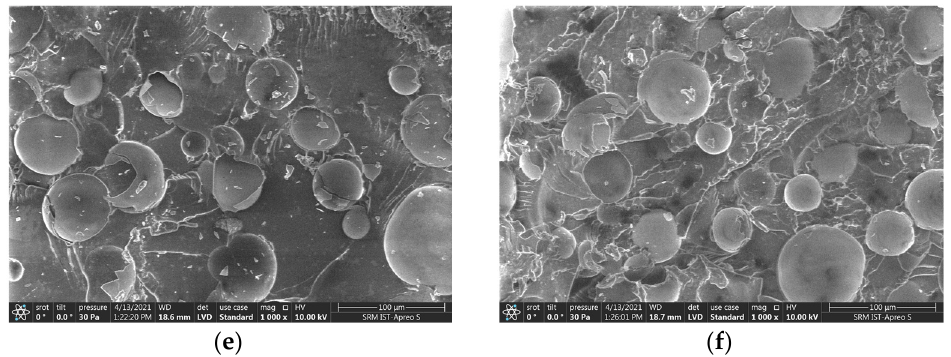
Figure 9. SEM micrographs of flexural fractured surfaces of ( a ) neat epoxy, ( b ) 2HGM/CNT/E, ( c ) 4HGM/CNT/E, ( d ) 6HGM/CNT/E, ( e ) 8HGM/CNT/E, and ( f ) 10HGM/CNT/E composite specimens.